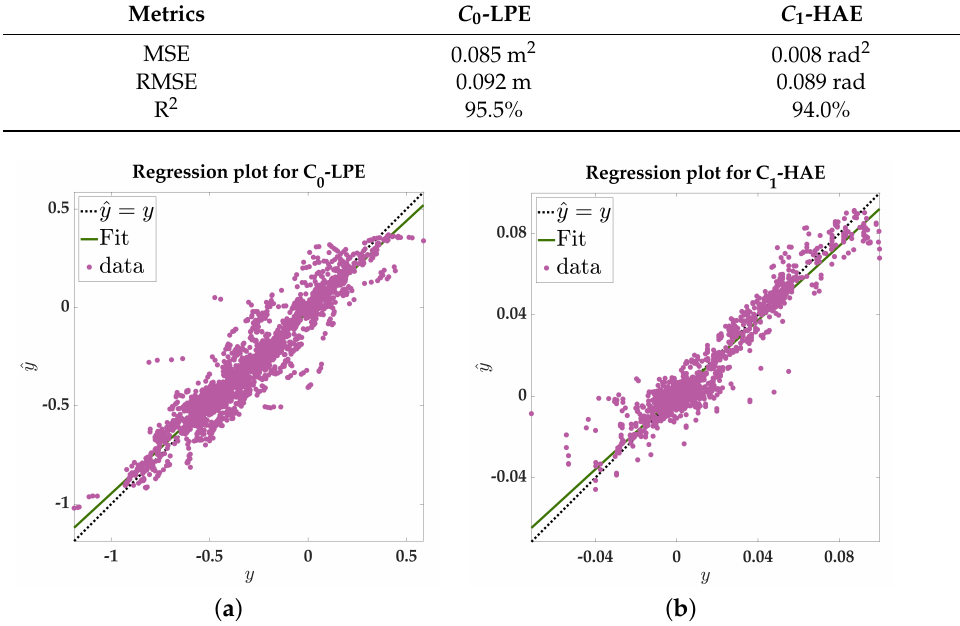
Figure 8. MLP training regression graph. ( a ) Training regression result for C 0 -LPE ( b ) Training regression result for C 1